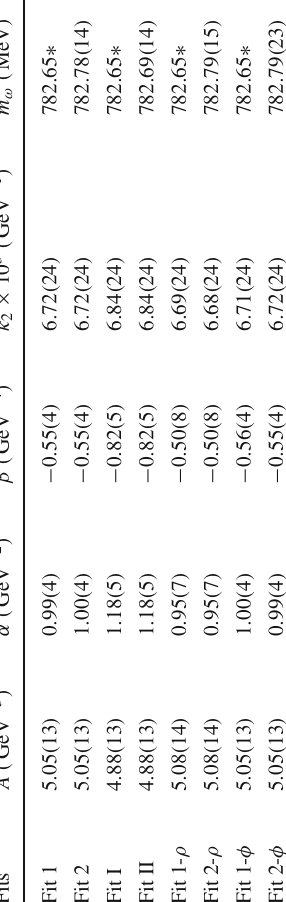
tribution provided by a 2 -exchange gave an estimate of this parameter, β = ( − 1 . 0 ± 0 . 1 ) GeV − 4 [18], which yields